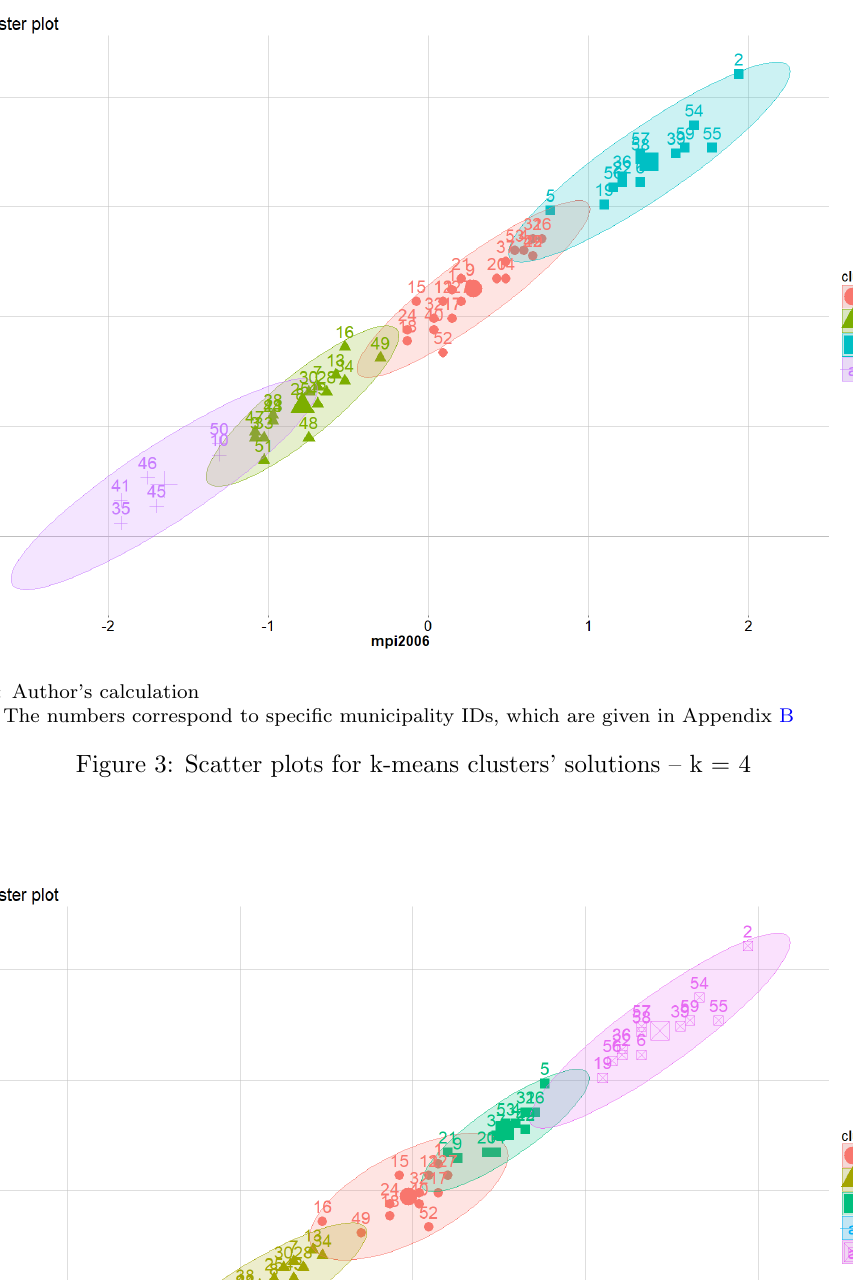
REGION : Volume 4, Number 3,